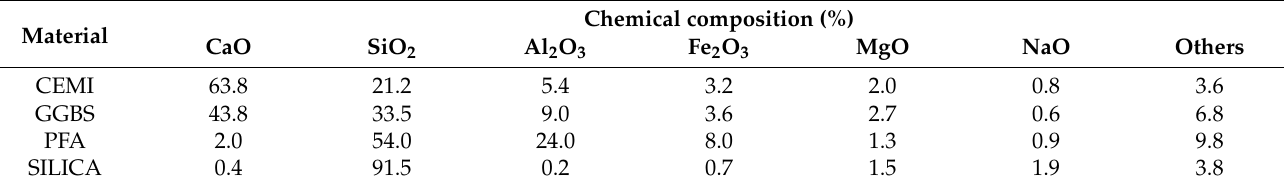
Table 20. Chemical composition of Cement and GGBS [83].